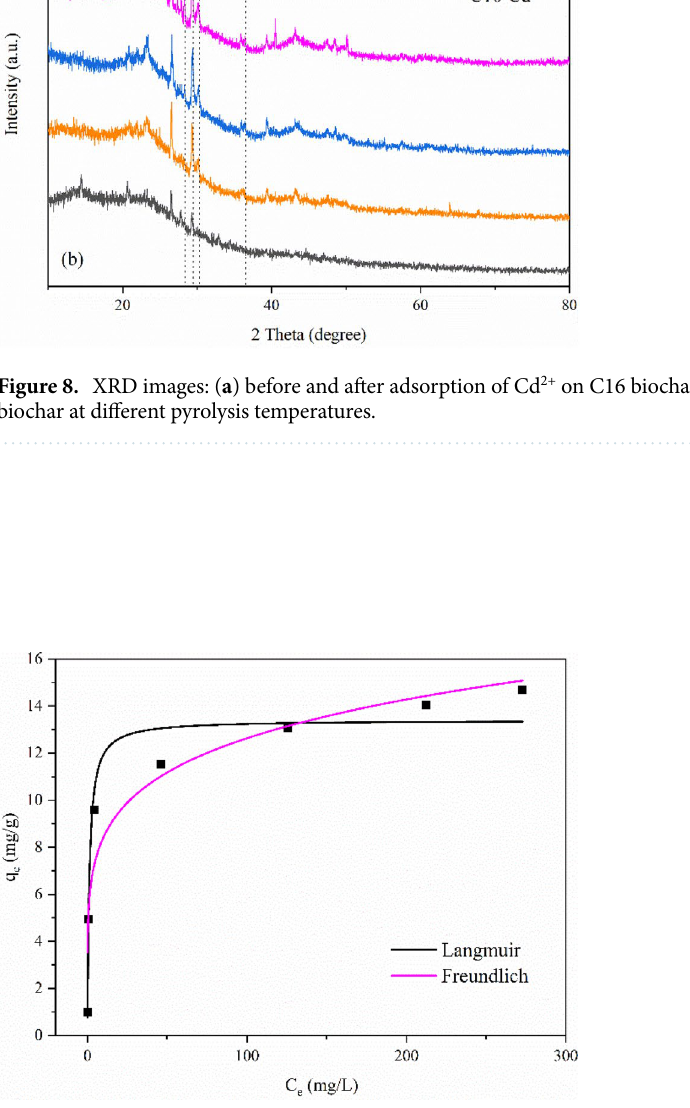
Figure 9. Adsorption